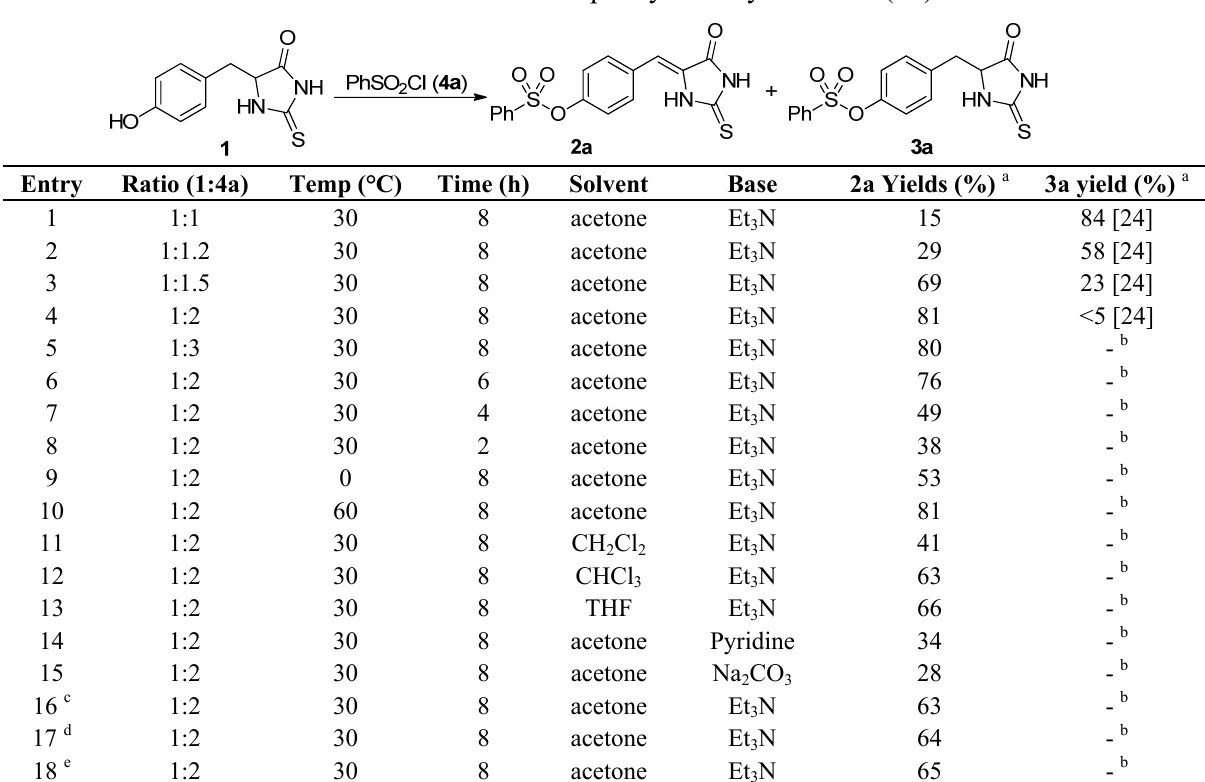
Table 1. The reaction of 1 and phenylsulfonyl chloride ( 4a